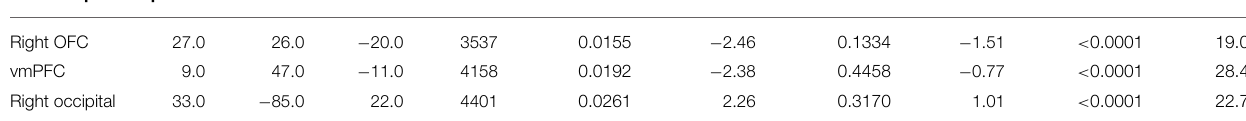
TABLE 3 | Summary of significant regions from Map 1. Region X Y Z Volume Regression vs. CARE Regression vs. BIS F -test (mm) (mm 3 ) P T P T P F From Map 1: Response Inhibition Contrast vs CARE Scores with CARE > BIS F -test CARE > BIS Right OFC Right occipital